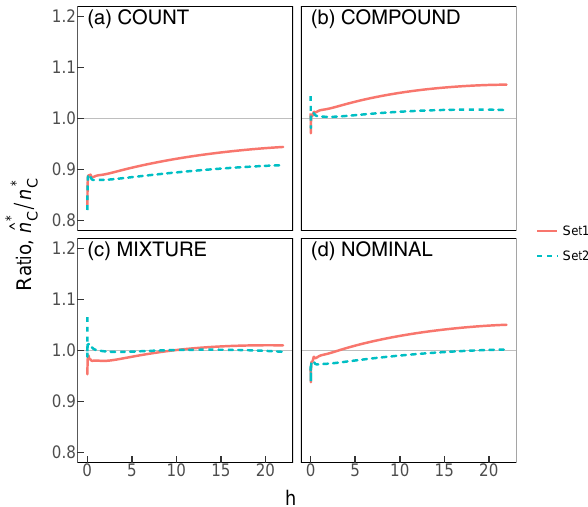
) and actual ( n ∗ ) number of mea- C C